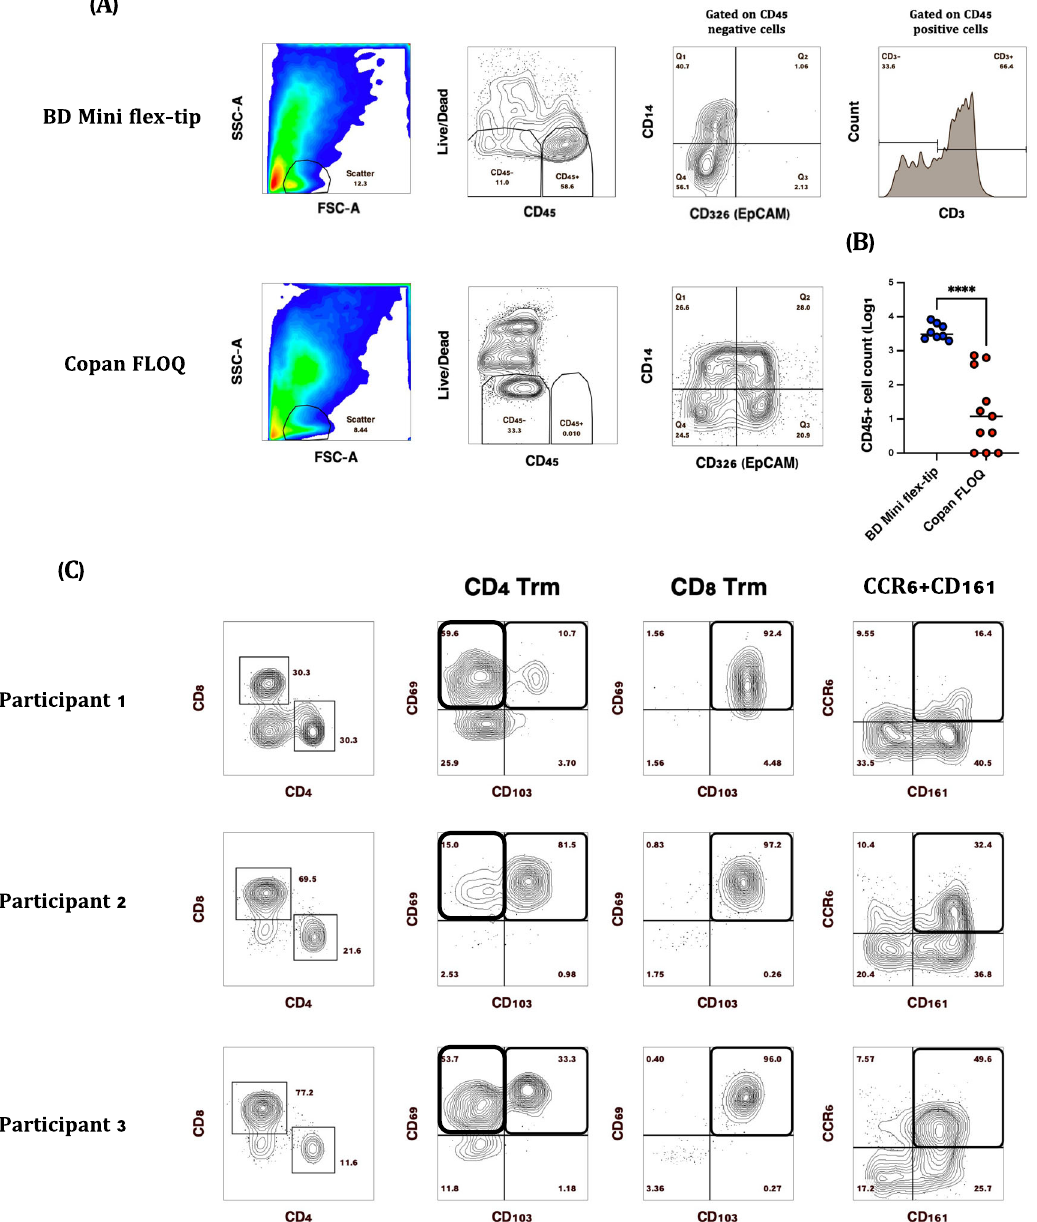
Fig. 1 Comparison of SARS-CoV-2 diagnostic testing nasopharyngeal (NP) swabs for immune cell recovery. Representative plots of CD45 + nasal immune cells isolated from ( A ) BD Mini Flex-tip swabs, majority of which (~40 – 90%) were CD3 + and Copan FLOQ swabs from which epithelial (CD326) (EpCAM + ) cells were the main cell type recovered. B A signi fi cant difference in CD45 + immune cell recovery was observed when BD Mini Flex-tip swabs were used compared to Copan FLOQ swabs (Mann – Whitney test, **** P > 0.0001). C Representative plots of CD3 + T cell subsets isolated from BD Mini-tip fl exible swabs. Majority of CD4 + and CD8 + T cells were Trm based on the expression of CD69 and or CD103, while 16 – 50% of CD4 + T cells were “ Th17- like ” based on the expression of CD161 and CCR6. was used for